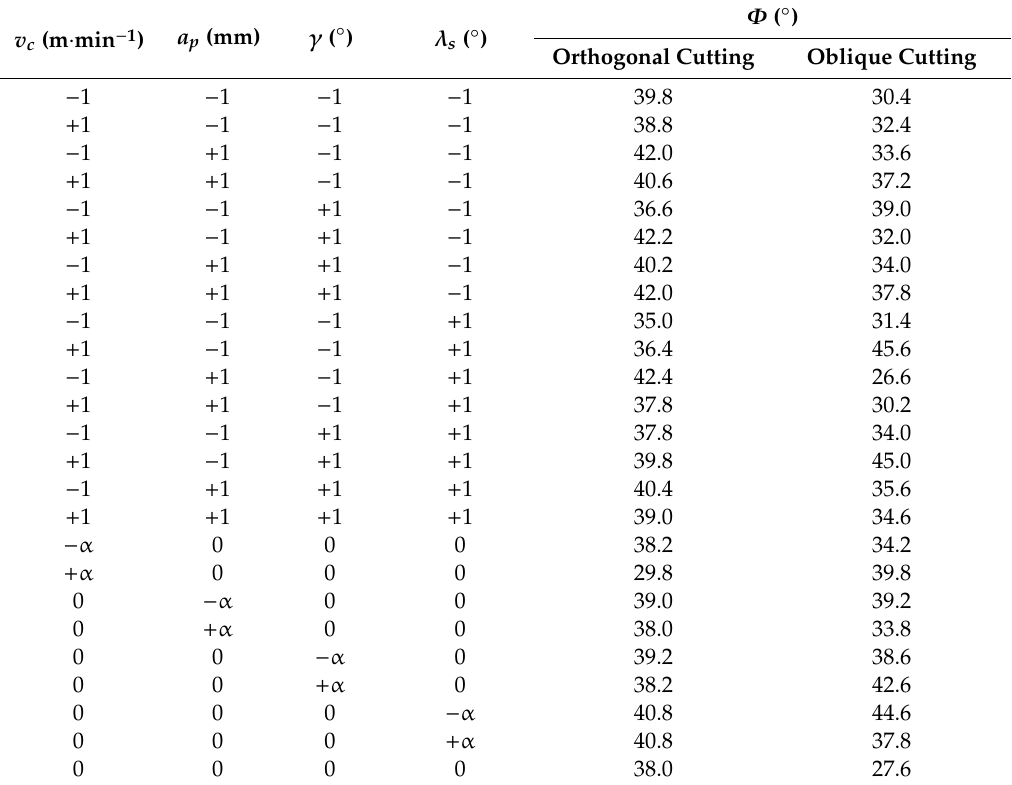
Table 6. Experimentally obtained values of temperature in cutting zone for orthogonal and oblique machining of EN C45